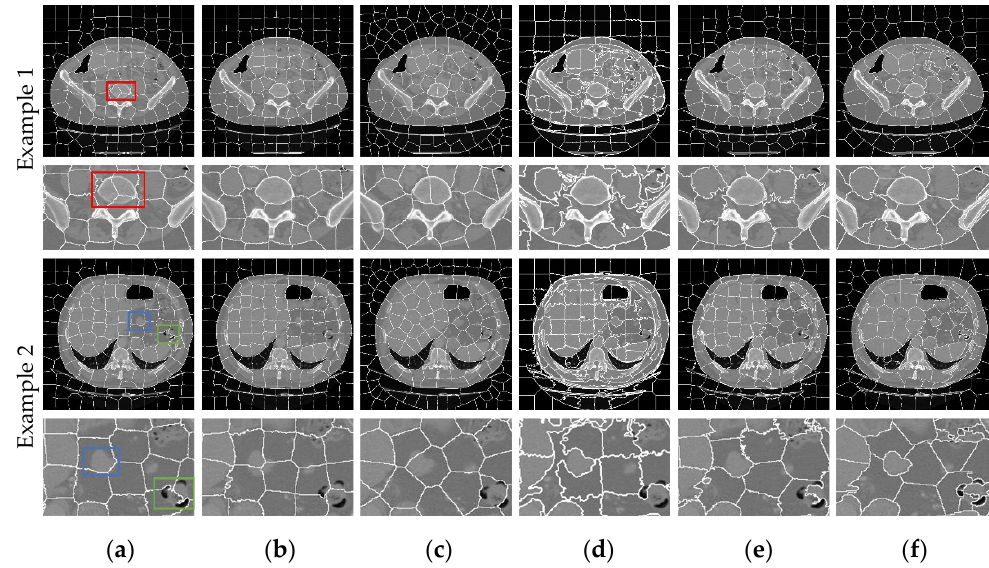
Figure 13. Experimental results on the medical image dataset 3Dircadb: ( a ) result of SLIC; ( b ) result of SNIC; ( c ) result of LRW; ( d ) result of USEAQ; ( e ) result of CAS and ( f ) result of our method. Alternating rows show the segmented results and their local details.